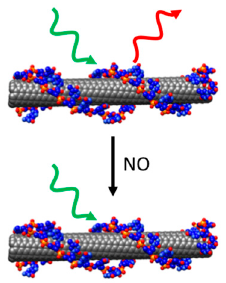
Figure 5. Schematic of a single wall carbon nanotube sensor for nitric oxide (NO) detection. The nanotube is excited by a 561 nm laser and emits 990 nm fluorescence when there is no NO present, but when NO is added to the system the fluorescence of the carbon nanotube is quenched [104,105].